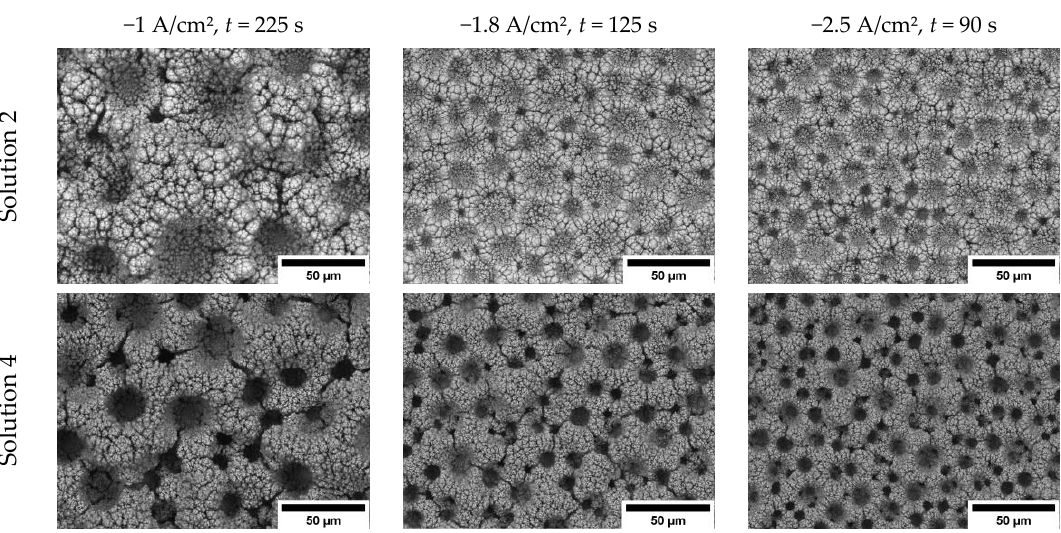
Figure 3. Scanning Electron Microscopy images of cobalt coatings obtained under a galvanostatic mode at various deposition conditions, but the same value of charge passed ( q = 180 C), from solutions containing isopropyl alcohol.